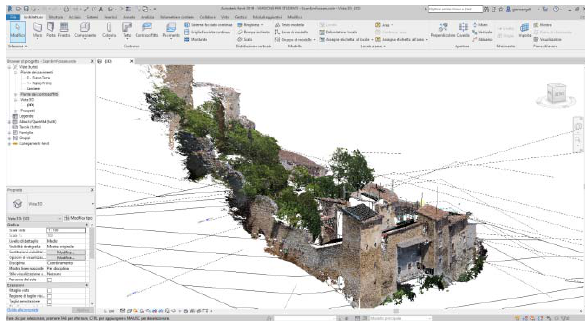
Figure 3: Screenshot of the point cloud of the castle obtained by the UAV survey imported in Revit.